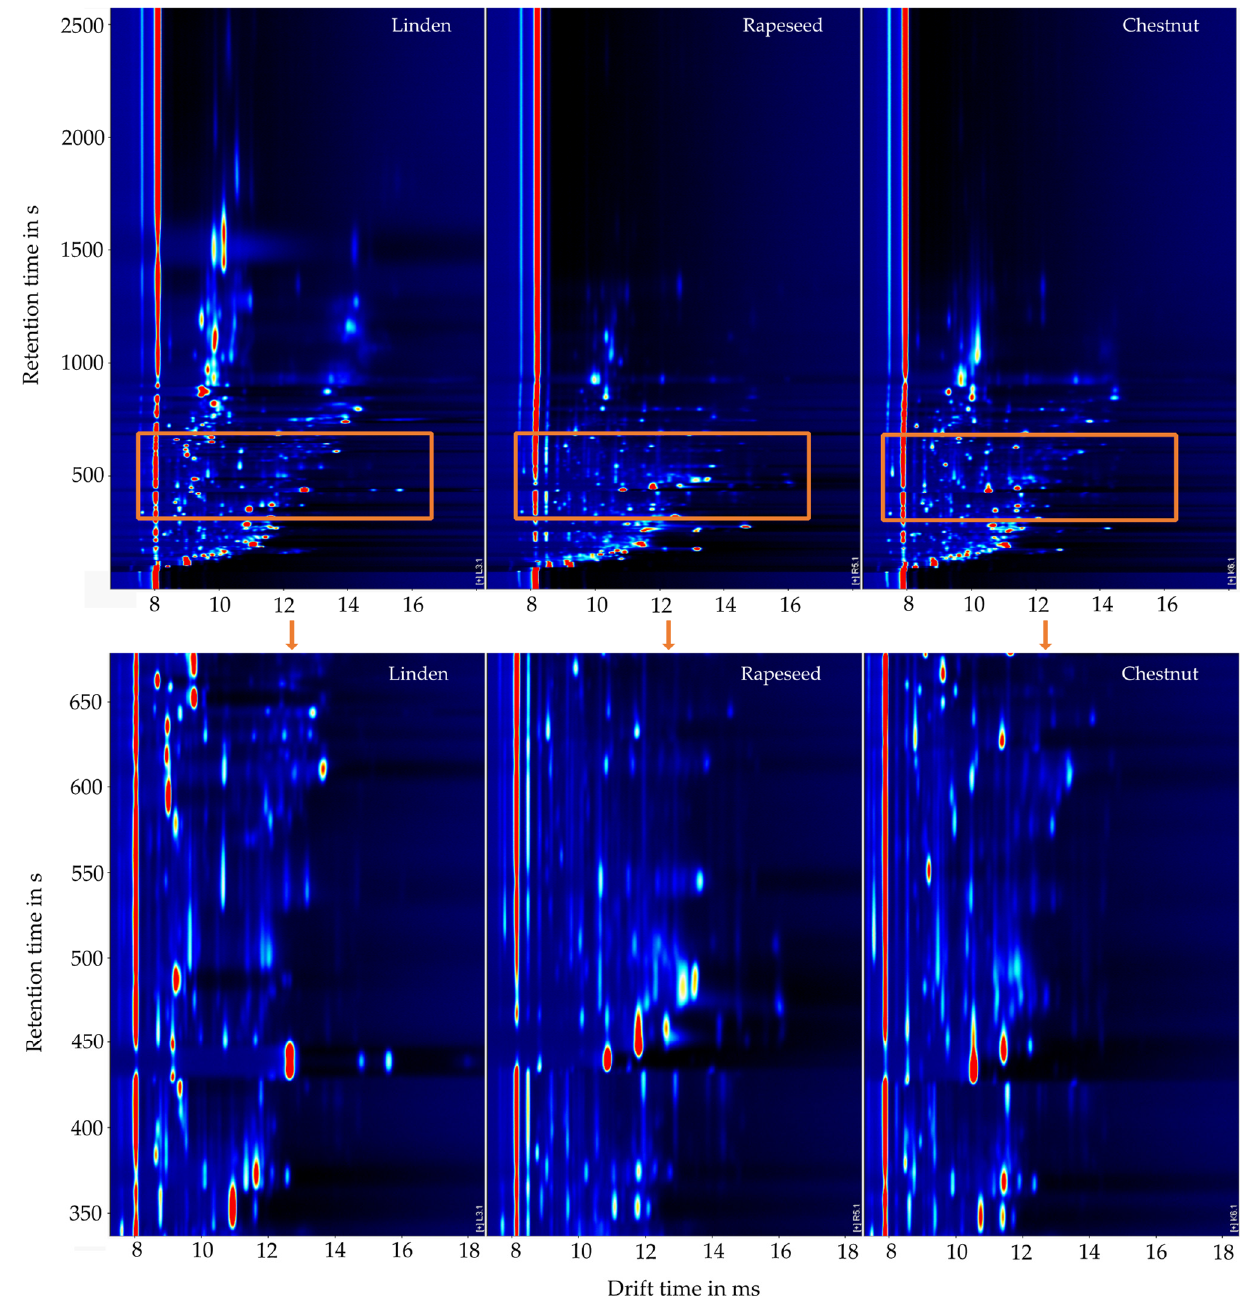
Figure 1. Gas chromatography ion mobility spectrometry (GCxIMS) plot of three honey types (from left to right: linden, rapeseed, and chestnut) in the upper part. In the lower part, the retention time range from 340 ms to 700 ms (orange rectangular) is enlarged.